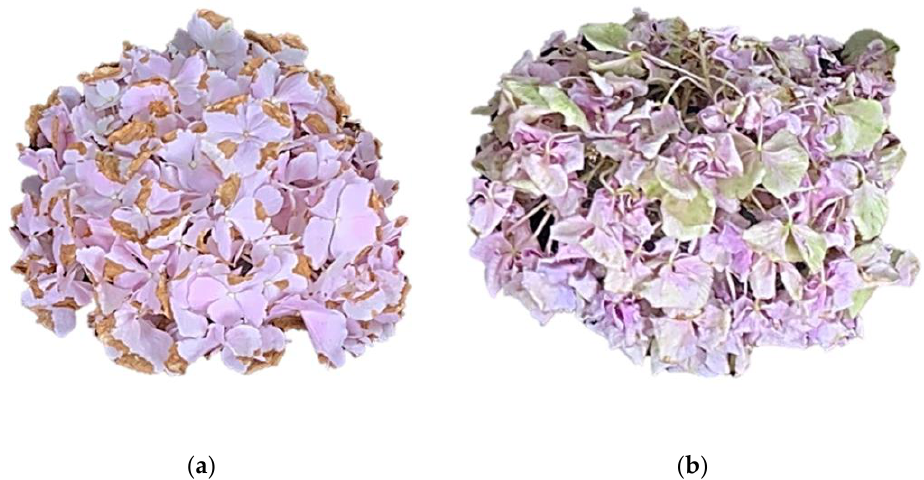
Figure 1. The main senescence symptoms of cut hydrangea flowers ‘Verena’ ( a ) browning ( b ) wilting.